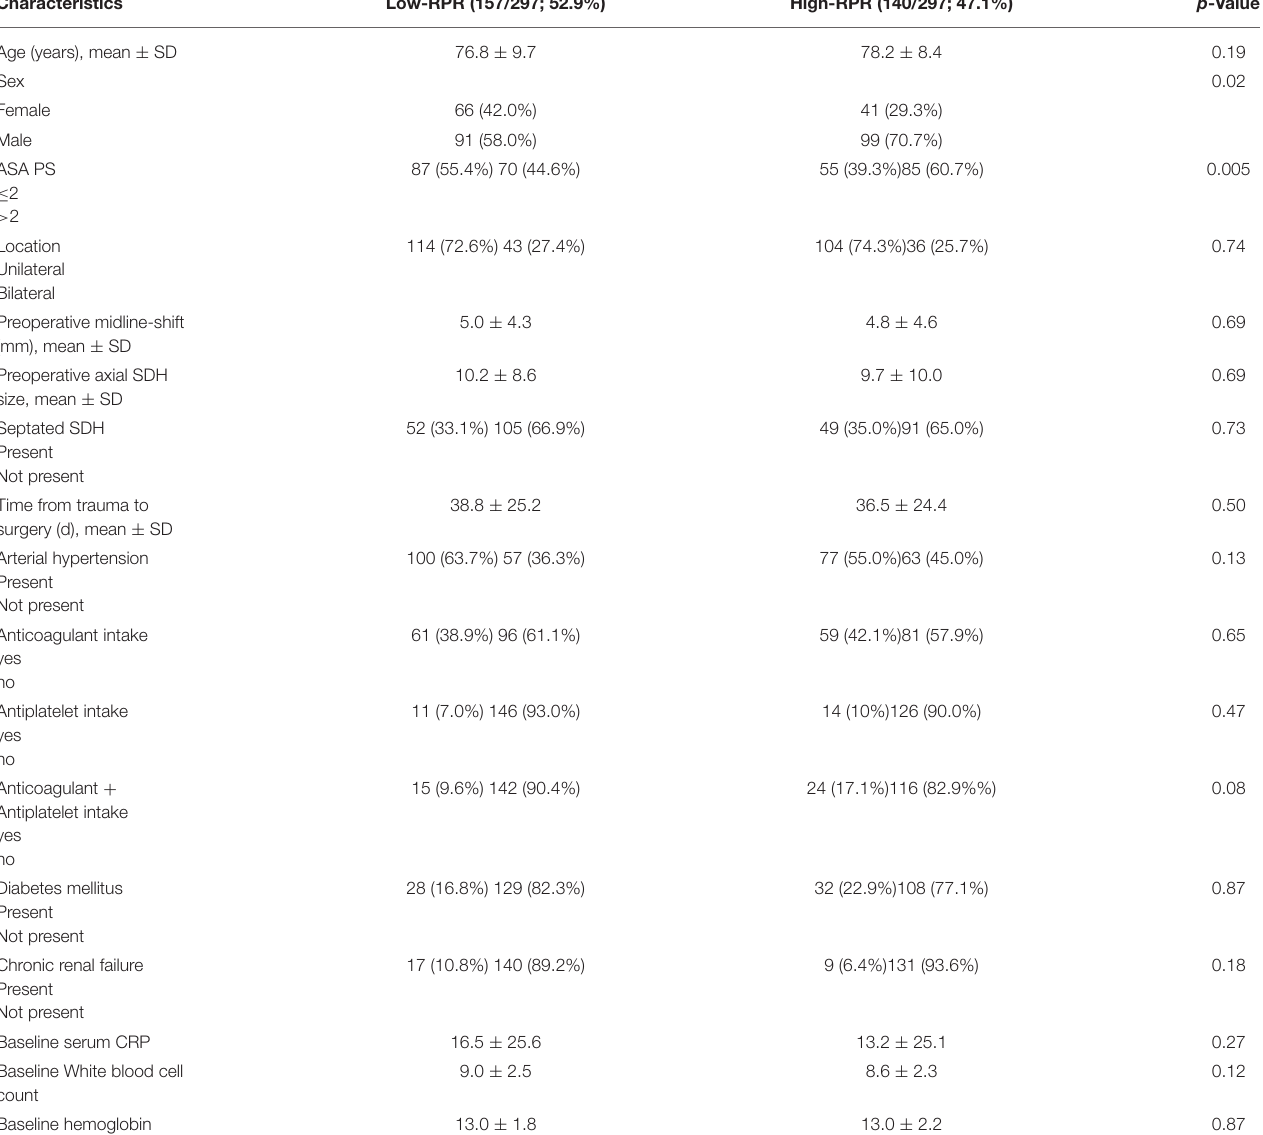
TABLE 1 | Comparison of low- vs. high-Red blood cell distribution width / Platelet Count ratio group (using Pearson’s chi-squared test (two-sided) and independent t -test).